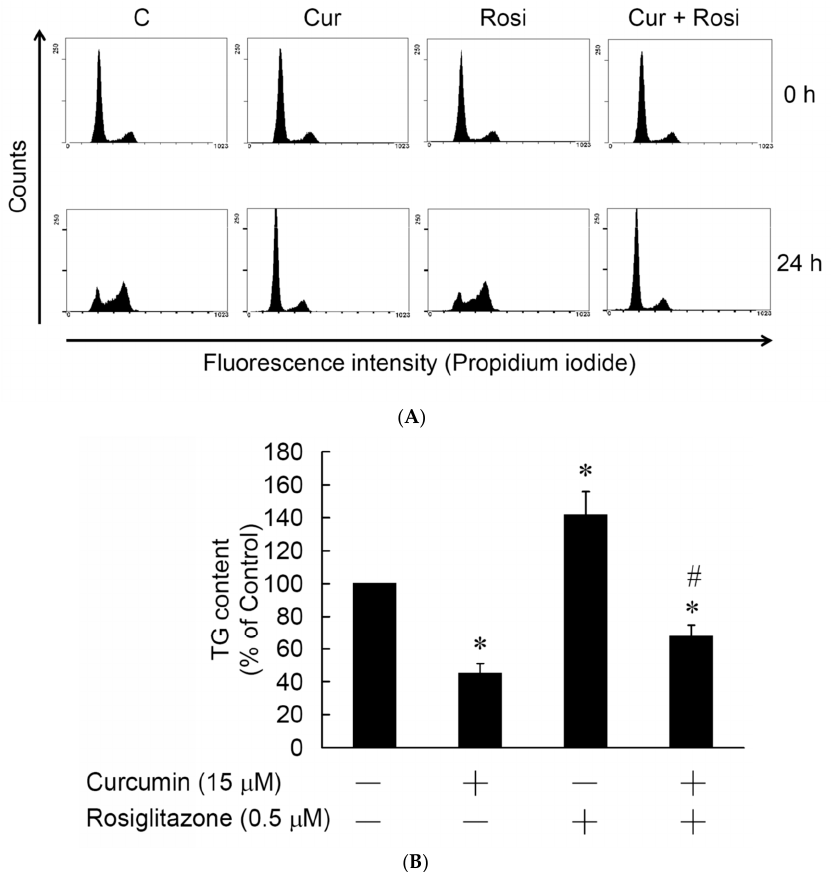
Figure 7. Lack of e ff ect of rosiglitazone on the inhibitory e ff ect of low dose curcumin on MCE and Figure 7. Lack of effect of rosiglitazone on the inhibitory effect of low dose curcumin on MCE and adipocyte di ff erentiation. 3T3-L1 preadipocytes were incubated for 1 h with or without 0.5 µ adipocyte differentiation. 3T3-L1 preadipocytes were incubated for 1 h with or without 0.5 µM